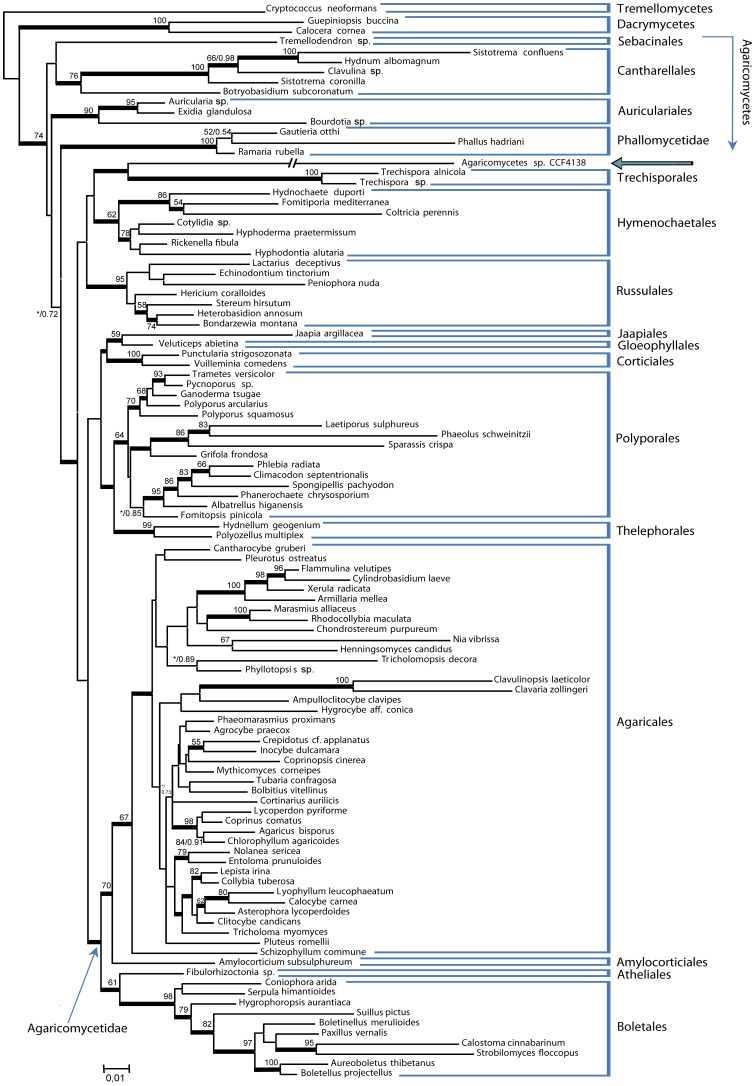
Phylogenetic relationship of 106 members of Agaricomycetes, including a representative of the novel basidiomycete.The representative of the novel basidiomycete (JPK 90 =  Agaricomycetes sp. CCF 4138) is marked with an arrow, the relationship is inferred from nuclear LSU, SSU and 5.8S rDNA genes; the new lineage forms a sister clade to Trechisporales and Hymenochaetales. Topology, branch lengths and bootstrap values above branches are from PhyML analyses. Thickened branches indicate Bayesian posterior probability ≥0.95. The branch leading to Agaricomycetes sp. CCF 4138 is approx. three-times shortened.